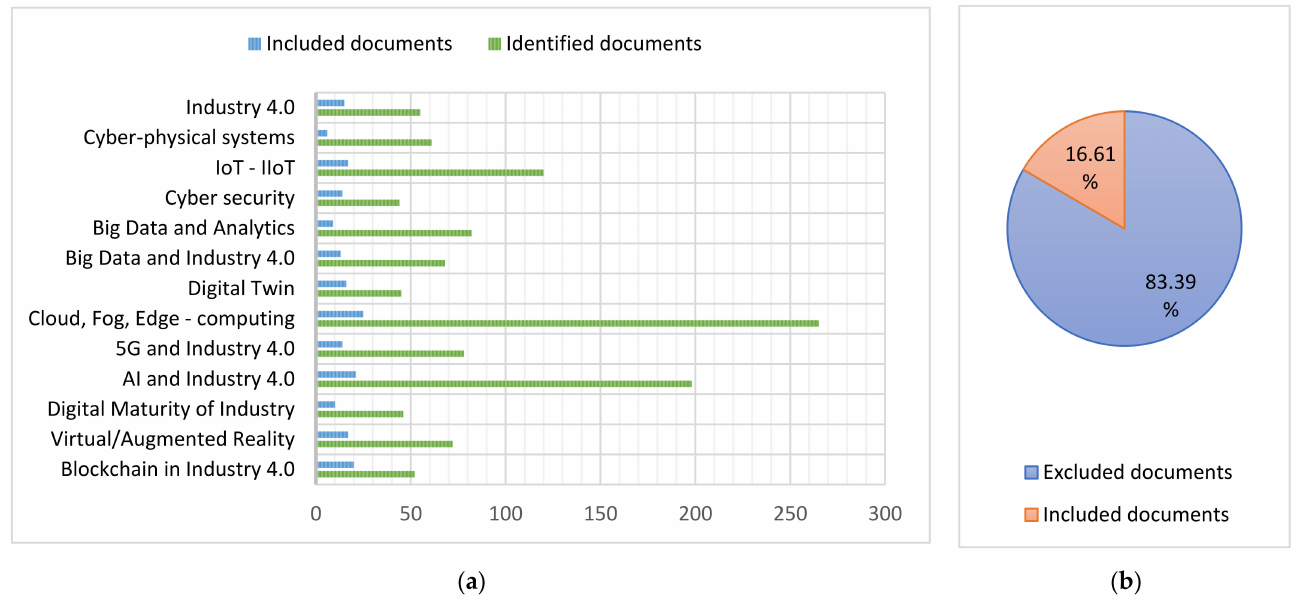
Figure 2. ( a ) Ratio of exclusion and inclusion of documents of each paradigm and key technology; ( b ) Percentage of documents included and excluded with respect to the